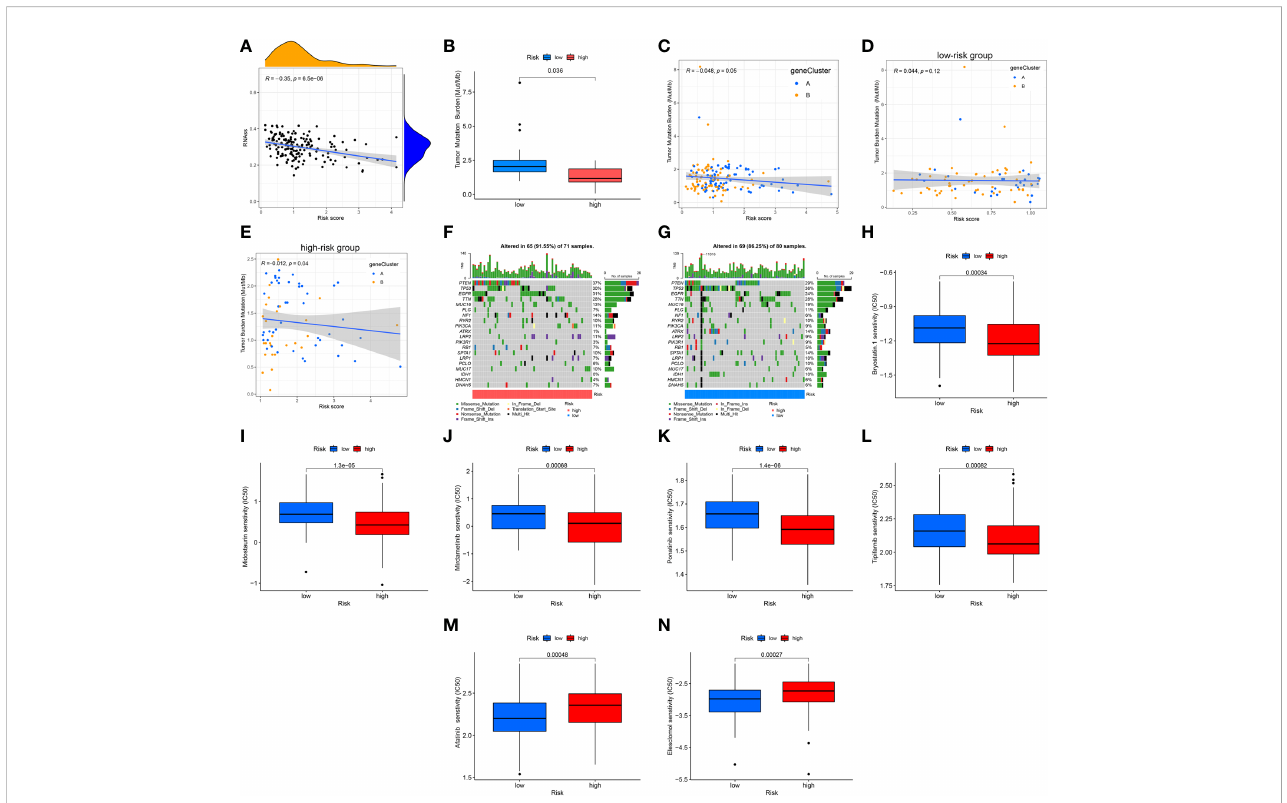
FIGURE 11 Association of risk score with CSC index, TMB, and drug sensitivity. (A) Correlation analysis between CSC indices and risk scores. (B) Differential analysis of TMB between the two risk groups. (C – E) Spearman correlation analysis between TMB and risk scores. (F, G) The waterfall plots of somatic mutation feature established with high- and low-risk scores. Each column represented an individual patient. The upper barplot showed TMB, and the number on the right indicated the mutation frequency in each gene. The right barplot showed the proportion of each variant type. (H – N) Differential analyses of IC50 values of common drugs or compounds. CSC, cancer stem cell; TMB, tumor mutation